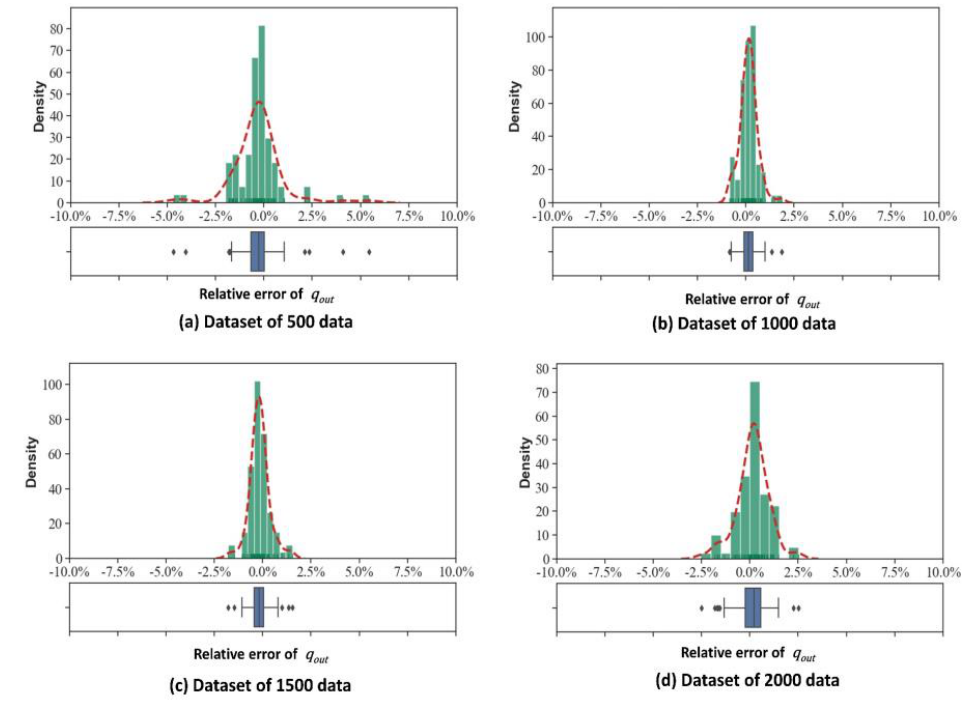
Figure 12. Error distribution density maps of 81 samples in test dataset with four dataset sizes: ( a )